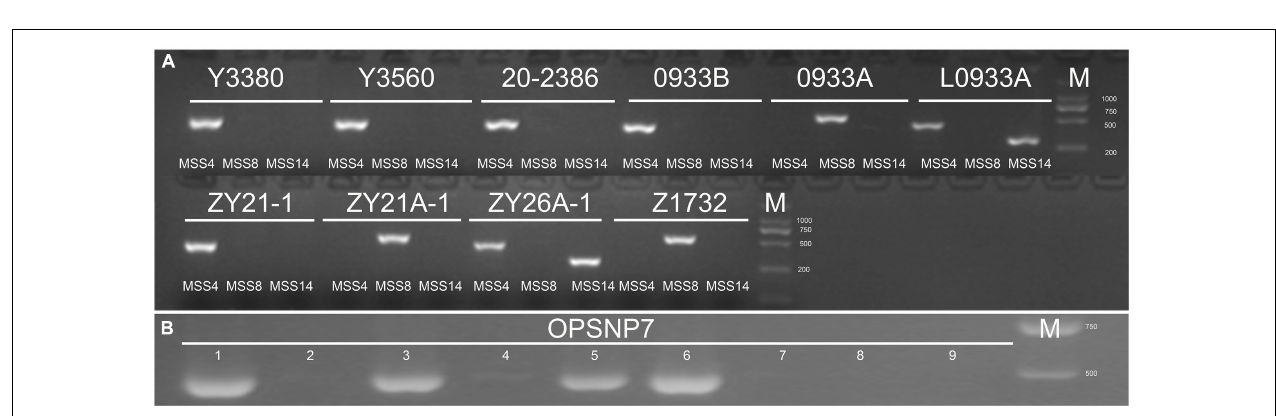
FIGURE 3 | Identification results of cytoplasmic genotype and pol CMS recovery gene Rfp1 . (A) Results of cytoplasmic identification with primers MSS-4 ( nap ), MSS-8 ( pol ) and MSS-14 ( ogu ). (B) Results of recovery gene identification, 1–9, respectively: 20-2386; 0933A control; Y3380-1, Y3380-2, Y3560-1, Y3560-2, 0933B, ZY21-1, ZY21A-1, and OPSNP7 are primers for the specific amplification of pol CMS restorer gene Rfp1 .